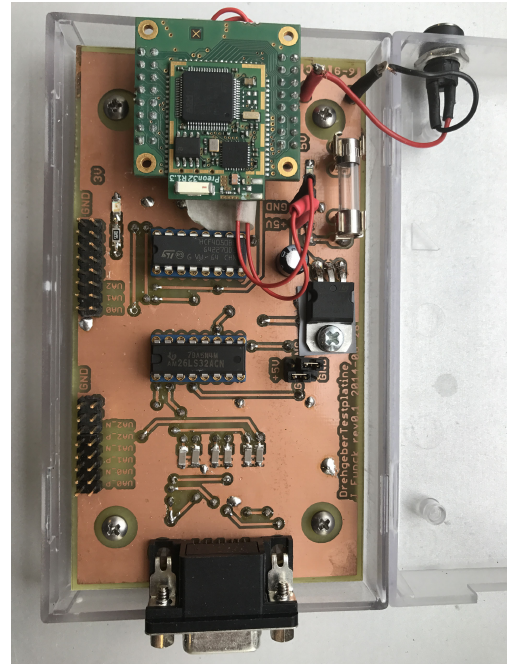
Figure 6. Conditioning board for the rotary encoder.